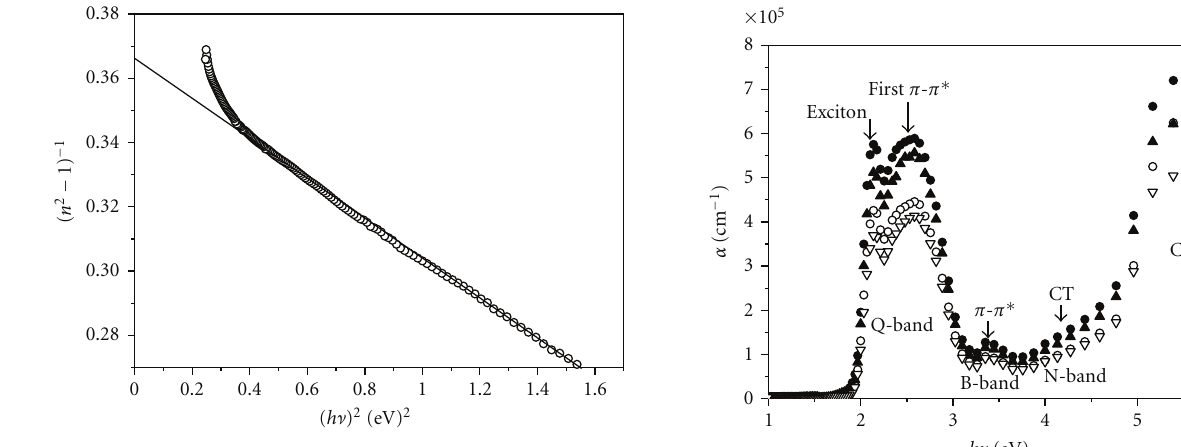
Figure 6: The plot of ( n 2 − 1) − 1 against ( h ν ) 2 for PTDCI films.